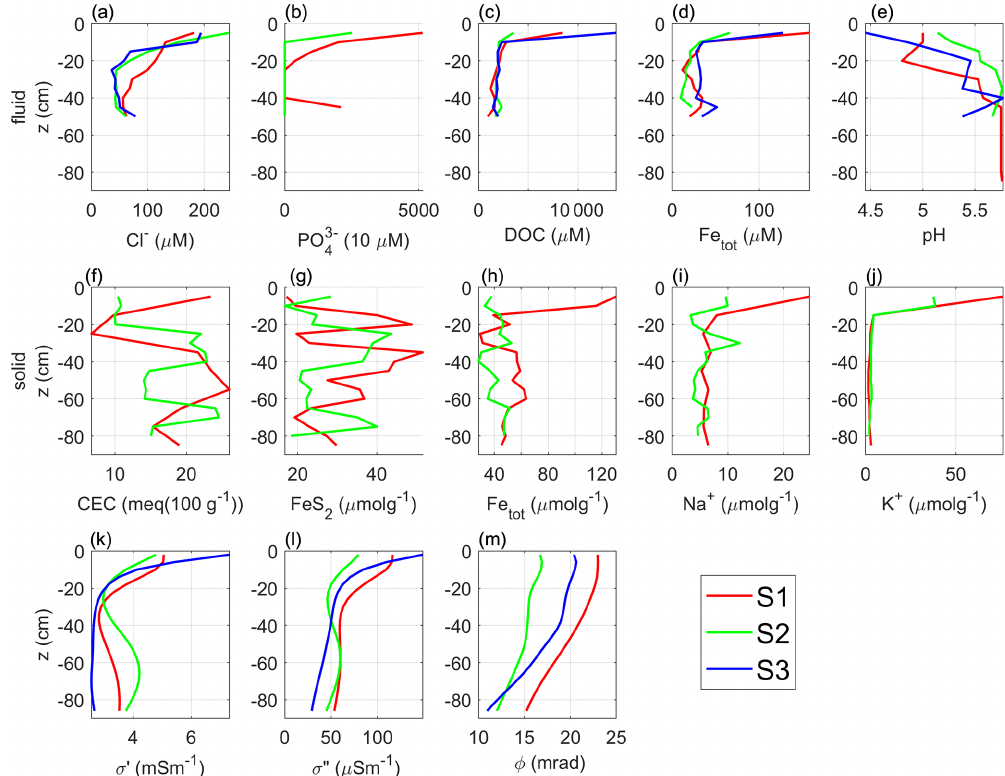
Figure 9. Results of geochemical analyses of water and soil samples. Fluid-sample analysis of the (a) chloride Cl − , (b) phosphate PO 3 − (c) dissolved organic carbon, (d) total iron Fe tot , and (e) pH. Freeze-core sample analysis of the (f) cation exchange capacity CEC, (g) iron sulfide FeS 2 , (h) total iron Fe tot , (i) sodium Na + , and (j) potassium K + . Imaging results at the three sampling locations in terms of (k) real component σ (cid:48) , (l) imaginary component σ (cid:48)(cid:48) , and (m) phase φ of the complex